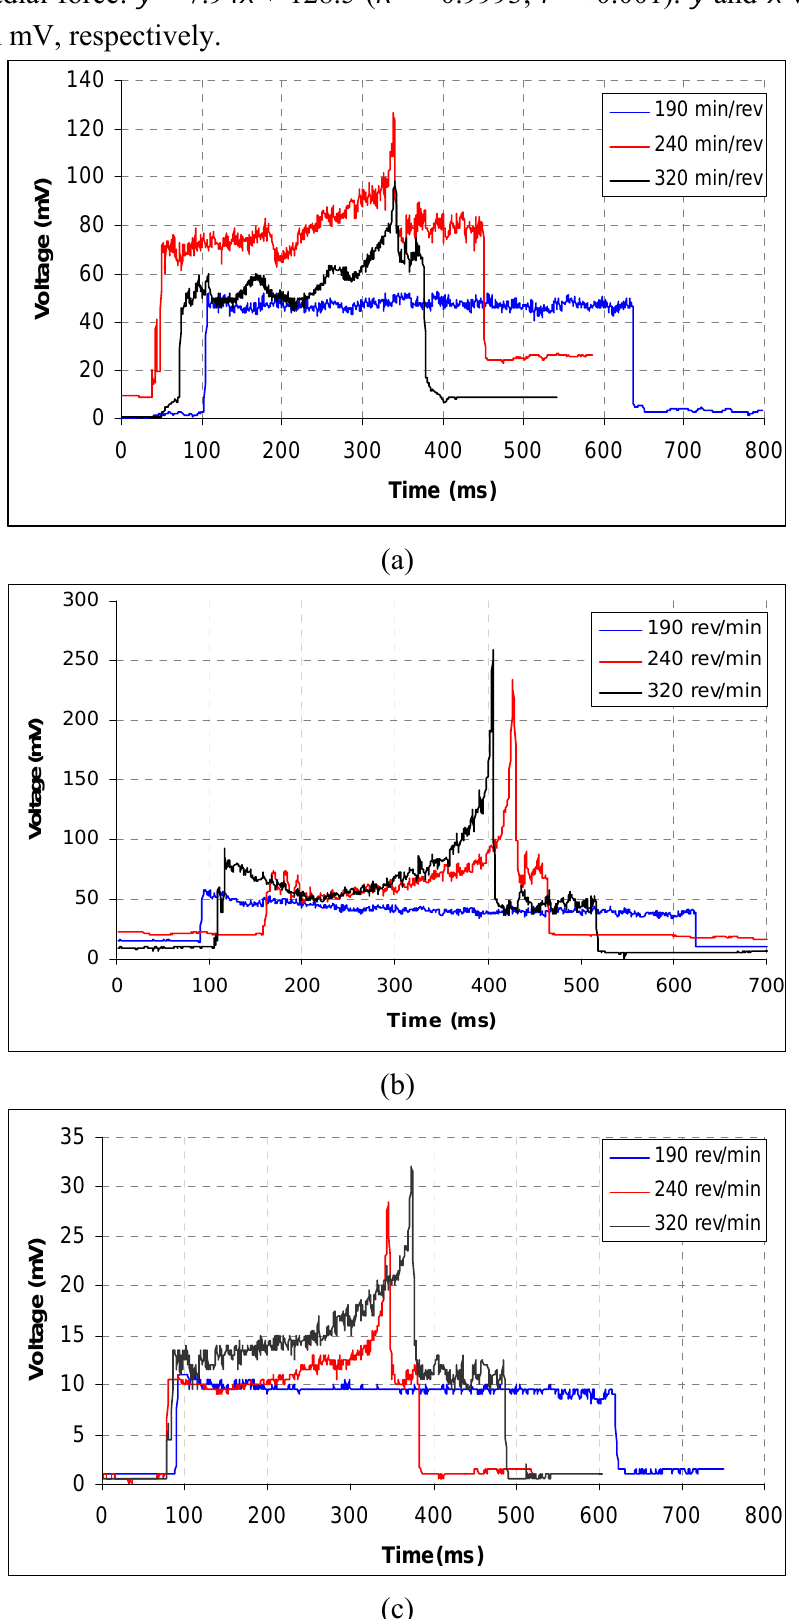
Figure 7 . Comparison of cutting forces at different rotational speeds at a feed speed of 0.081